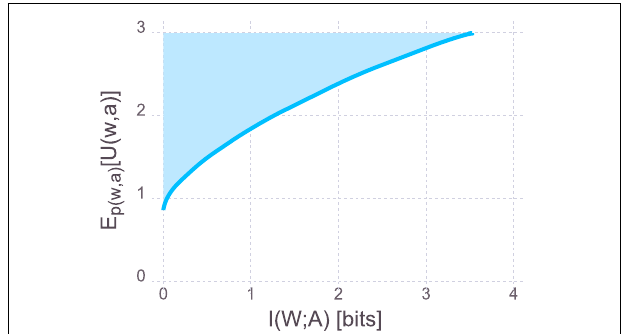
FIGURE 4 | Rate-utility curve . Analogously to the rate-distortion curve in rate-distortion theory, the rate-utility curve shows the minimally required information processing rate to achieve a certain level of expected utility or dually, the maximally achievable expected utility, given a certain rate. Systems that optimally trade-off expected utility against cost of computation lie exactly on the curve. Systems in the shaded region are theoretically impossible and cannot be realized. Systems that lie in the white region of the figure are sub-optimal in the sense that they could achieve a higher expected utility given their computational resources or they could achieve the same expected utility with lower